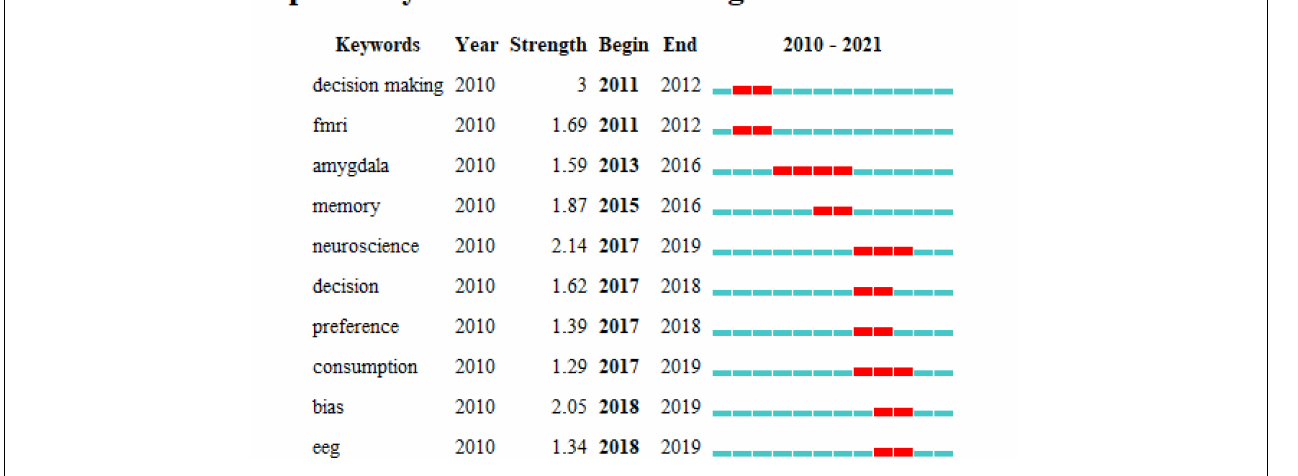
FIGURE 3 | The top 10 keywords with the strongest citation bursts from 2010 to